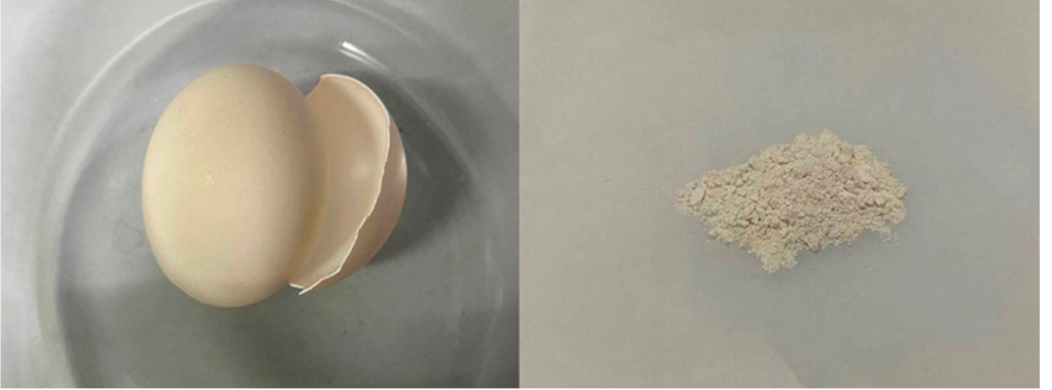
Figure 1. Raw eggshells and eggshell powder.